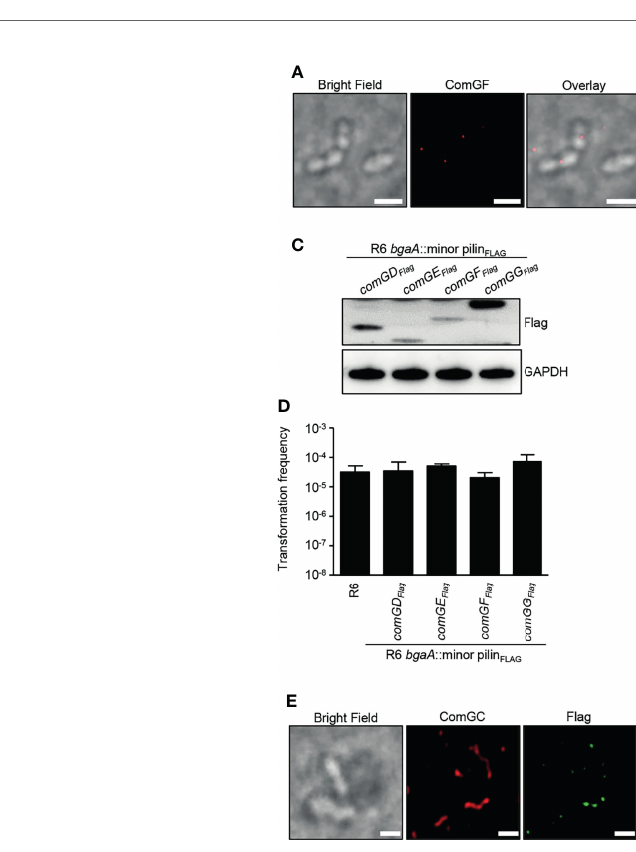
( Figure 5E ). In contrast, ComGD-Flag, ComGE-Flag or ComGG-Flag could not be detected despite repeated attempts.